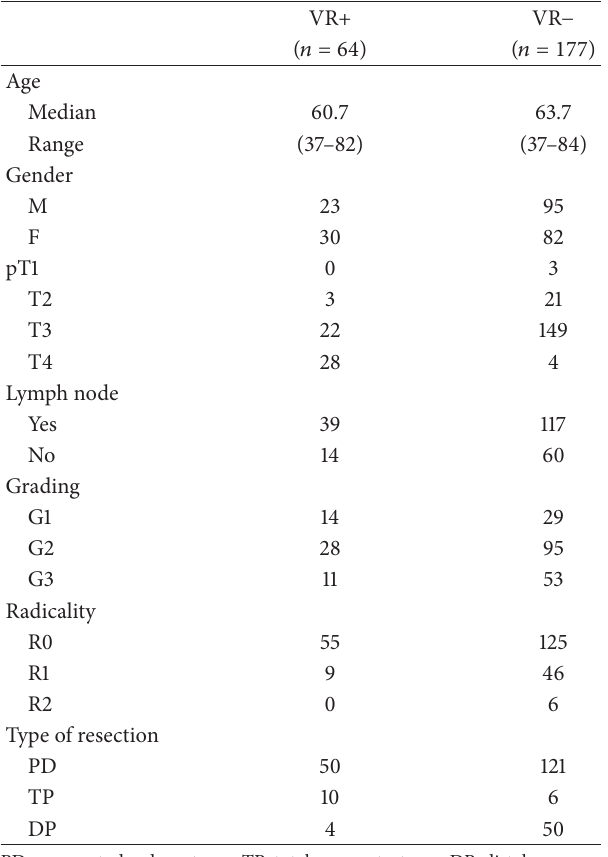
Table 1: Clinicopathological features of patients subjected to pan- creatic resection with (VR+) and without (VR − ) vascular